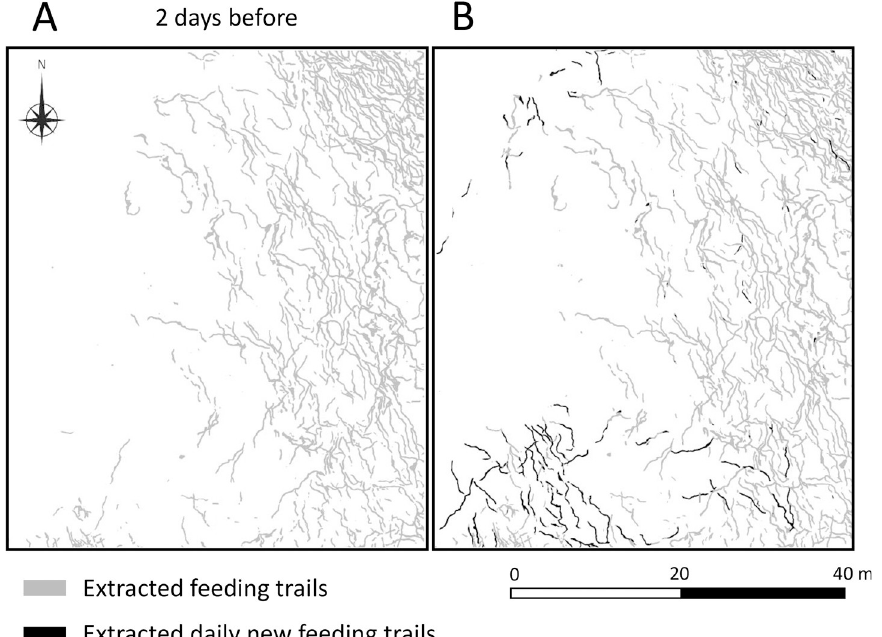
Fig 14. Example of the extracted daily new feeding trails; (A) feeding trails extracted from the orthophoto image of 2 days before and (B) feeding trails extracted from the orthophoto image of a certain day. The gray area shows feeding trails extracted by the Model_1. The black area (B) shows new daily feeding trails extracted by the Model_2 and is overlayed on the feeding trails extracted by the Model_1.